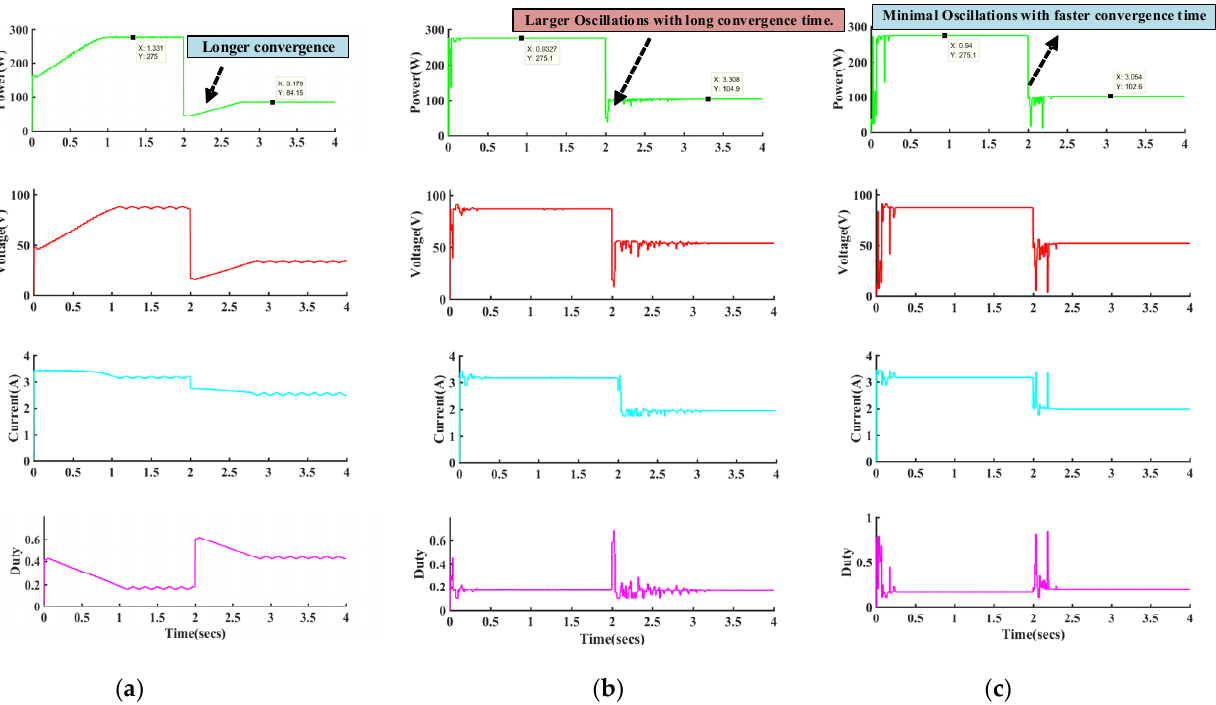
Figure 17. Simulated waveforms of ( a ) P& O, ( b ) PSO, and ( c ) SHO methods for pattern change in 5S1P configuration from uniform irradiation to Pattern 5.